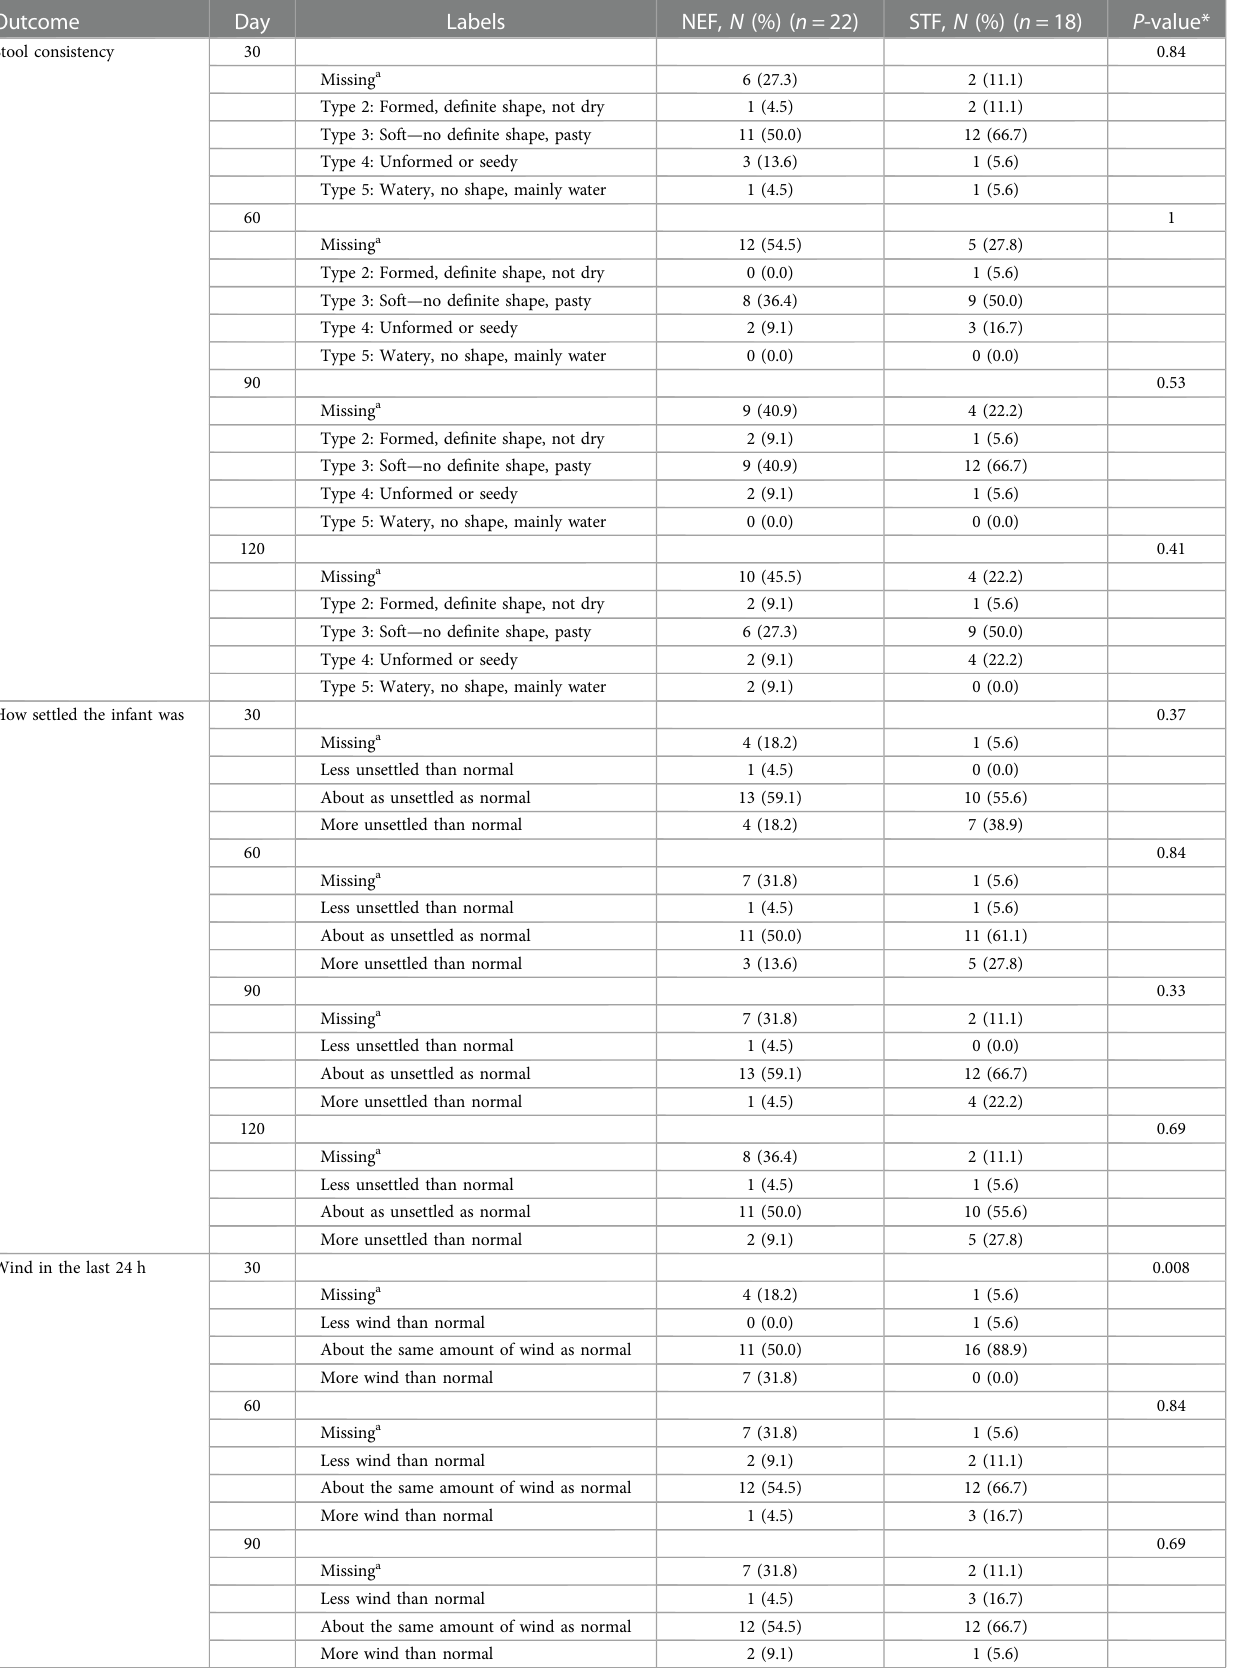
TABLE 4 Formula